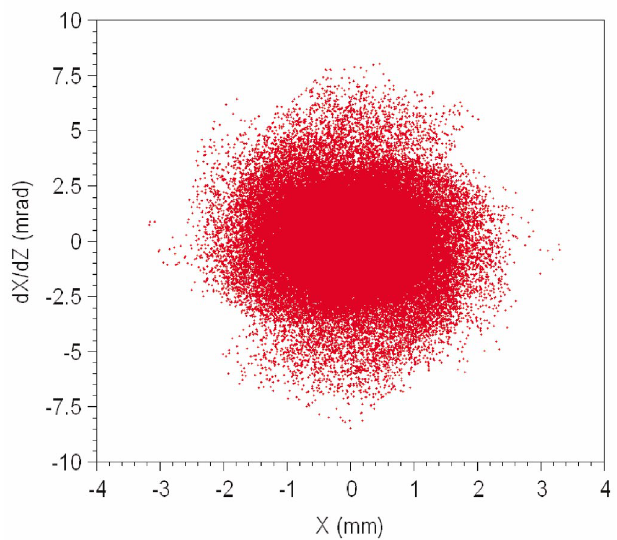
FIG. 32. (Color) The phase portrait in the longitudinal plane at the linear accelerator